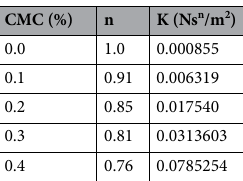
Table 2. Values of dynamical viscosity of the base fluid (CMC-Water), see Zhuang and Zhu 10 .